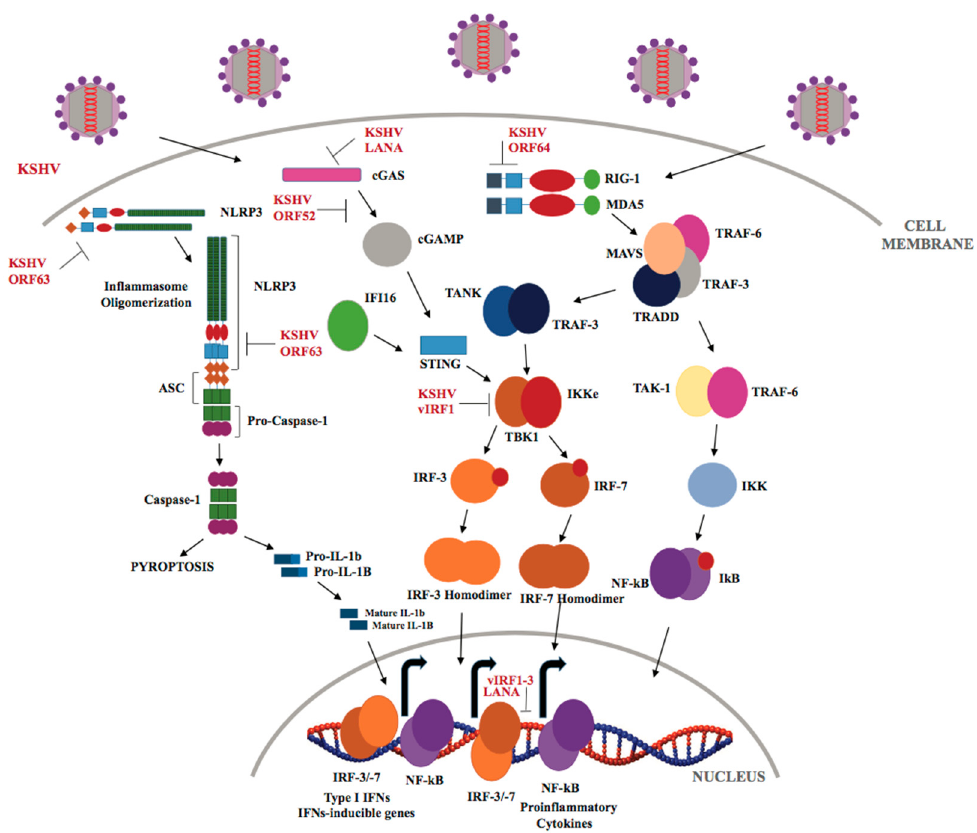
Figure 4. KSHV regulation of NLR, RLR, and cGAS-STING signaling pathways. Following KSHV entry into the host cell, the capsid extrudes KSHV dsDNA in the cytoplasm which is sensed by cGAS resulting in the STING/TBK1/IRF3 signaling and type I IFNs production. KSHV dsDNA is transcribed into dsRNA polymerase III and sensed by RIG-I and MDA-5, leading to activation and polymerization of MAVS and activation of NF- κ B. KSHV also controls the inflammatory responses via NLRP-1/3-dependent caspase-1 activation and inhibition of IL-1 β and IL-18 production.